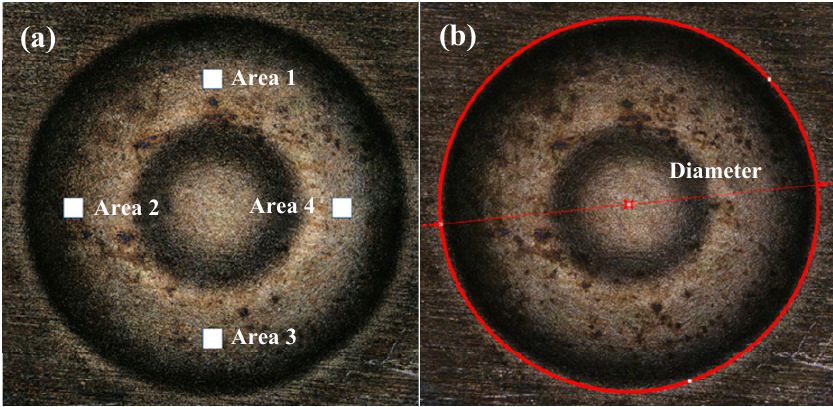
Figure 3. ( a ) Detection of surface roughness; ( b ) Detection of shape precision.